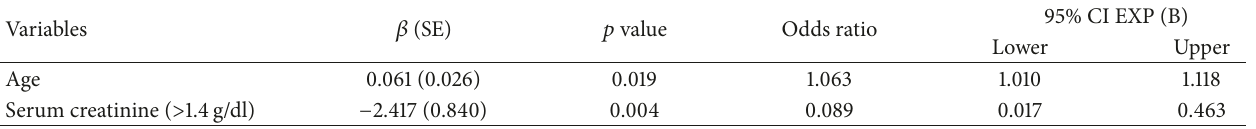
Table 3: Regression model for predicting mortality of ICU patients with scrub typhus ( 𝑛 = 120